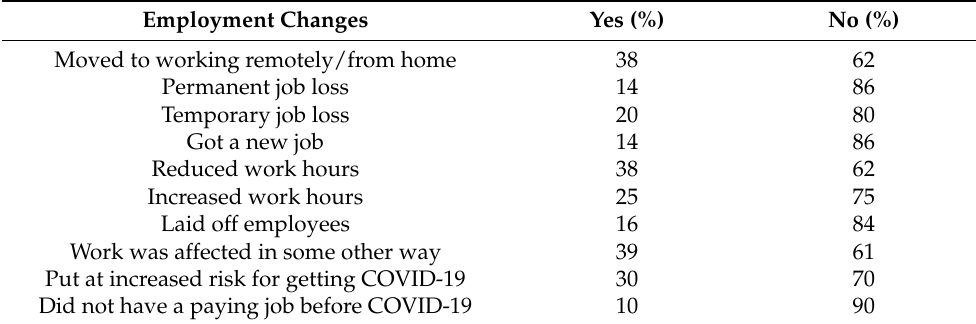
Table 2. Parent-reported impacts of the COVID-19 pandemic on employment ( n = 1000). Employment Changes